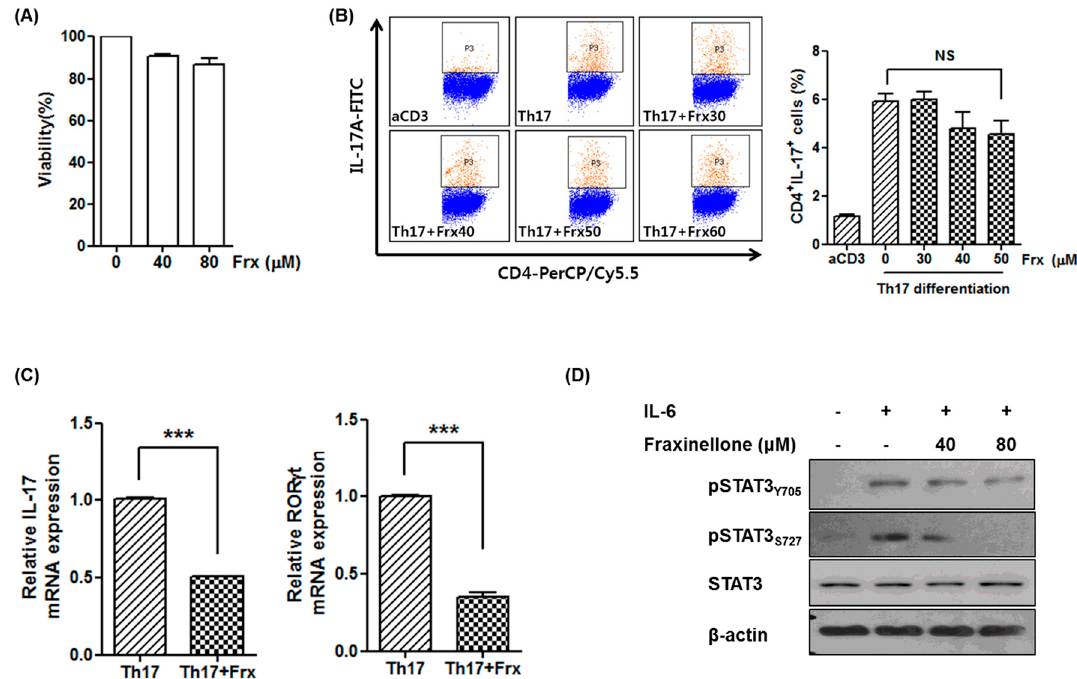
Figure 2. Fraxinellone inhibits Th17 differentiation. ( A ) Cell viability was evaluated using Cell Counting Kit-8 after treatment with 0, 40, and 80 μ M of fraxinellone. Doses of fraxinellone with cell viability over 80% were considered tolerable. ( B ) CD4 + T cells were differentiated into Th17 cells in the presence of various doses of fraxinellone. The proportion of CD4 + IL-17A + cells was measured by flow cytometry. ( C ) Relative mRNA expression of IL-17 and ROR γ t after treatment with or without fraxinellone was determined by reverse transcriptase-polymerase chain reaction (RT-PCR). CD4 + T cells were cultured with or without fraxinellone (40 μ M) under Th17-favoring conditions. Data represent the mean of three independent experiments ± SEM. NS, not significant; *** p < 0.001. ( D ) Expression of STAT3 in CD4 + T cells in the presence or absence of fraxinellone was evaluated using Western blot analysis. CD4 + T cells were stimulated with IL-6, and the expression levels of STAT3 and phospho-STAT3 were determined by Western blot analysis. Frx, fraxinellone; aCD3, stimulation with anti-CD3 antibodies; ROR γ t, RAR-related orphan receptor γ t; STAT3, signal transducer and activator of transcription 3; pSTAT3 Y705 , phosphor-STAT3 at Tyrosine 705; pSTAT3 S727 , phosphor-STAT3 at Serine 727.